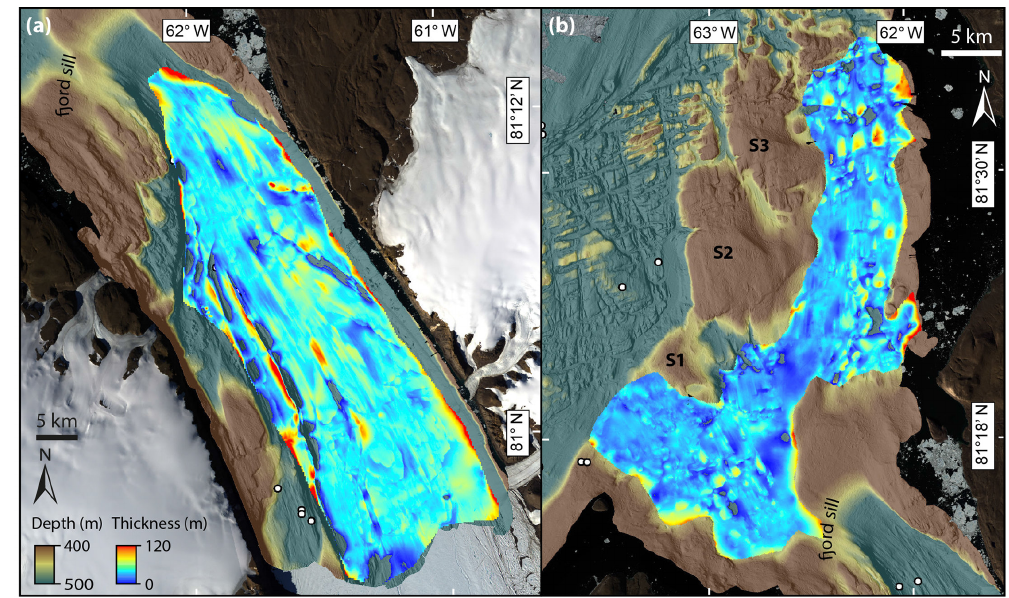
Figure 11. Isopach maps of the deglacial sediment pile for (a) Petermann Fjord and (b) the inner Hall Basin.